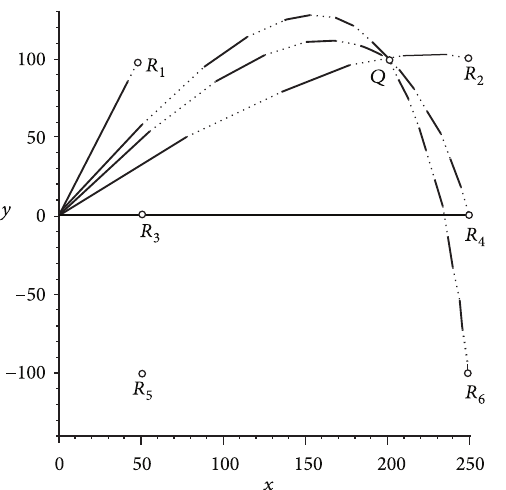
Figure 11: Planning trajectories through six different targets, touch- ing a line at each